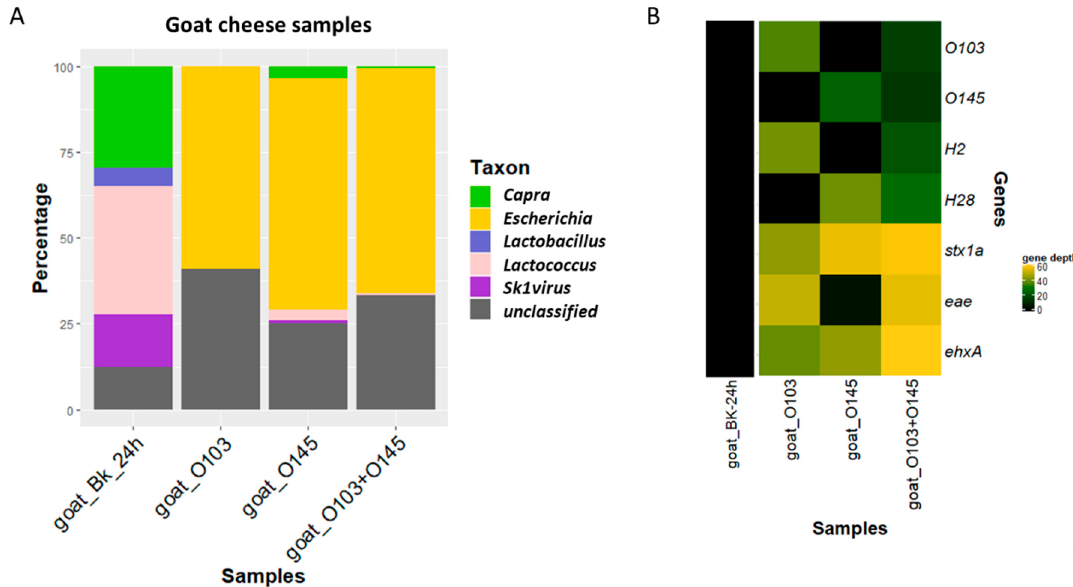
Figure 6. ( A ) Percentages of reads classified to the genus level using Kraken2 (taxonomic classification tool) on all reads of goat cheese samples with in-house databases of mammals, archaea, bacteria, fungi, human, protozoa, and viruses. Green represents the proportion of “ Capra ” corresponding to goat reads. Yellow represents the presence of “ Escherichia ” in the sample. The reads that could not be classified to the genus level for mammals, archaea, bacteria, fungi, human, protozoa, or viruses are represented in gray. ( B ) Gene depth per million trimmed reads per sample of wzx and fliC genes for the determination of types O103, O145, H2, and H28 and stx1a, eae, and ehxA virulence genes with more than 80% coverage and 80% identity in all reads of goat cheese samples. Increasing depth (per million trimmed reads) is represented in shades of green to yellow according to the color gradient in the legend. Goat_Bk_24h = Blank goat cheese enriched for 24 h. Goat_O103 = goat cheese spiked with STEC O103. Goat_O145 = goat cheese spiked with STEC O145. Goat_O103 + O145 = goat cheese co- spiked with STEC O103 and STEC O145.